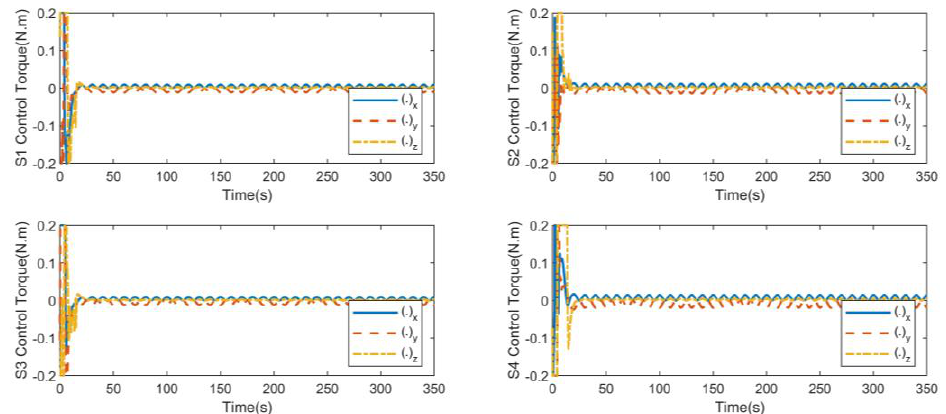
Figure 13. S1, S2, S3, S4 control force for consistent collaborative control.